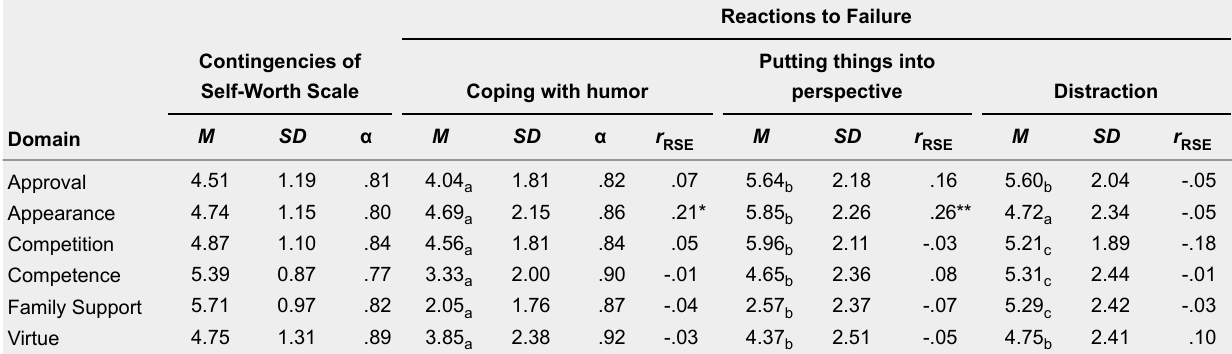
Descriptive Statistics for Contingencies of Self-Worth and Reactions to Failure in Domains of Self-Worth Contingency: Descriptive Statistics and Correlations with the Rosenberg-self-Esteem Scale